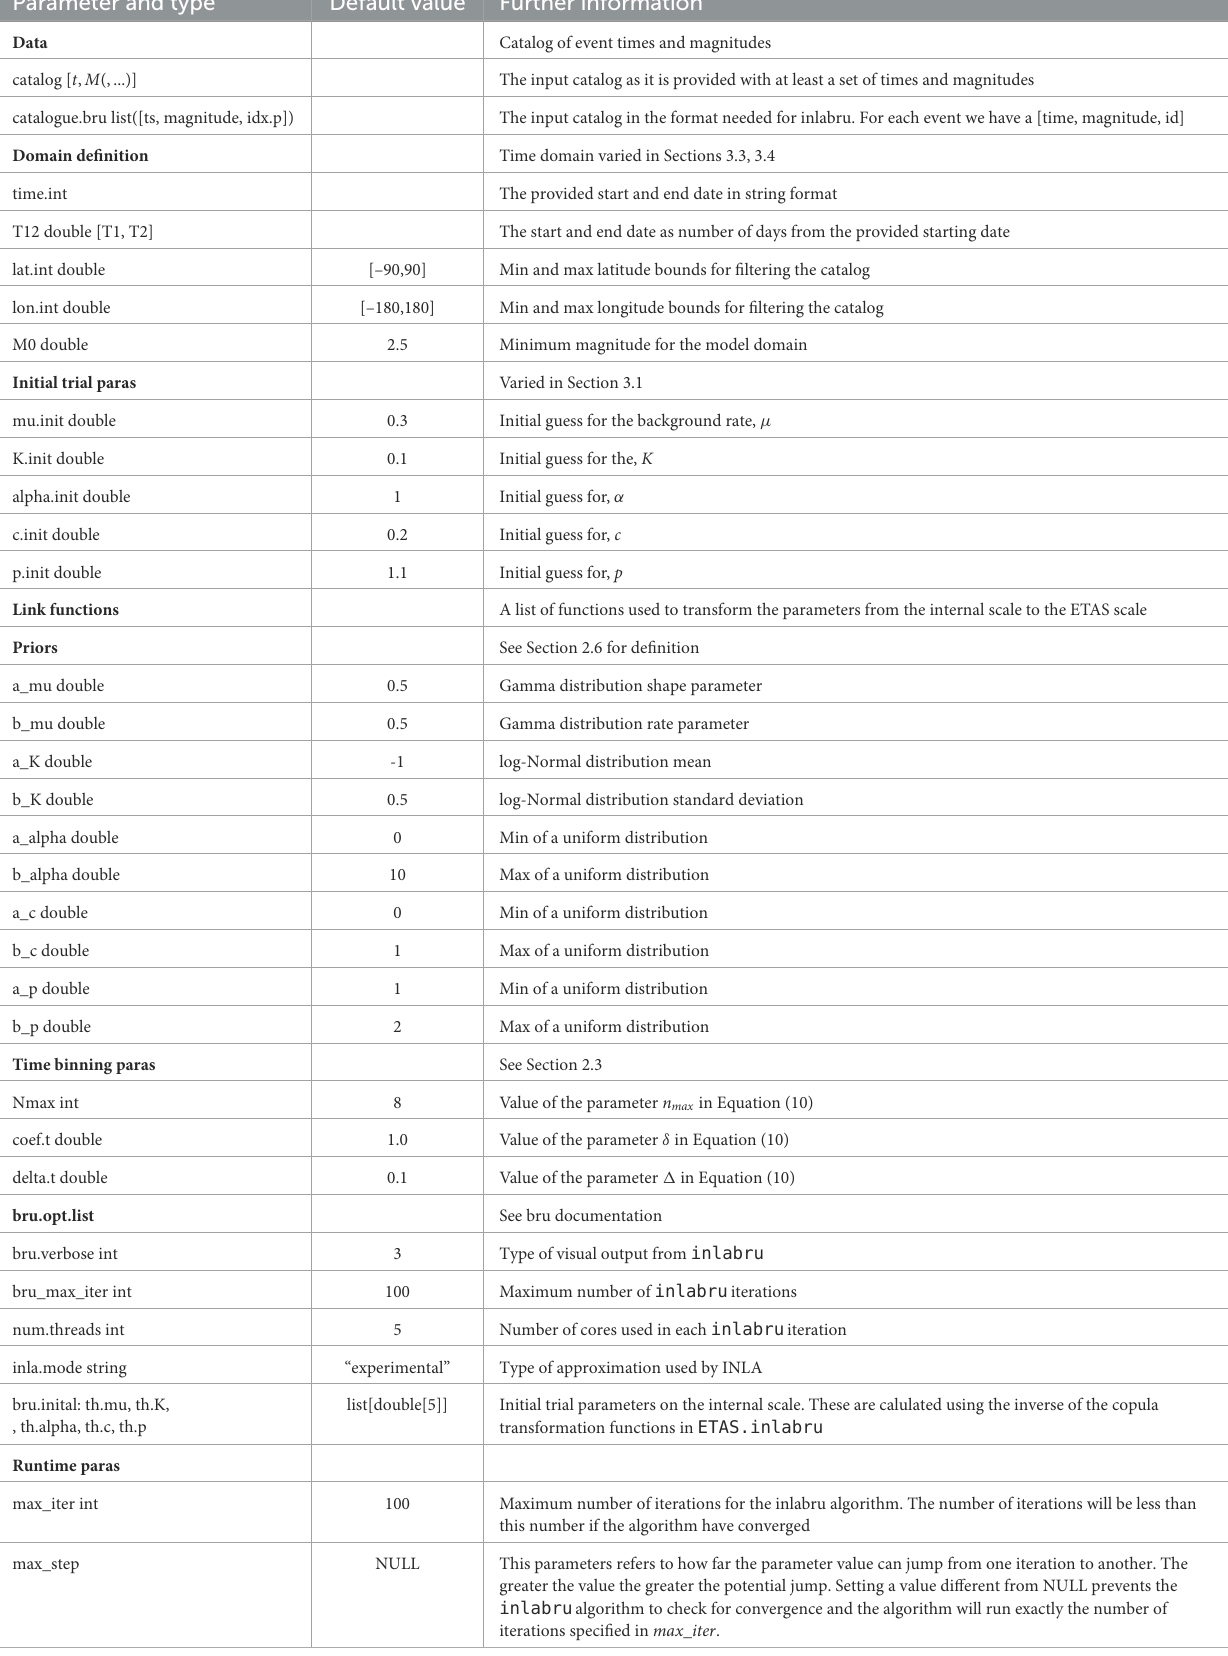
TABLE 2 Description of the model definition contained in list